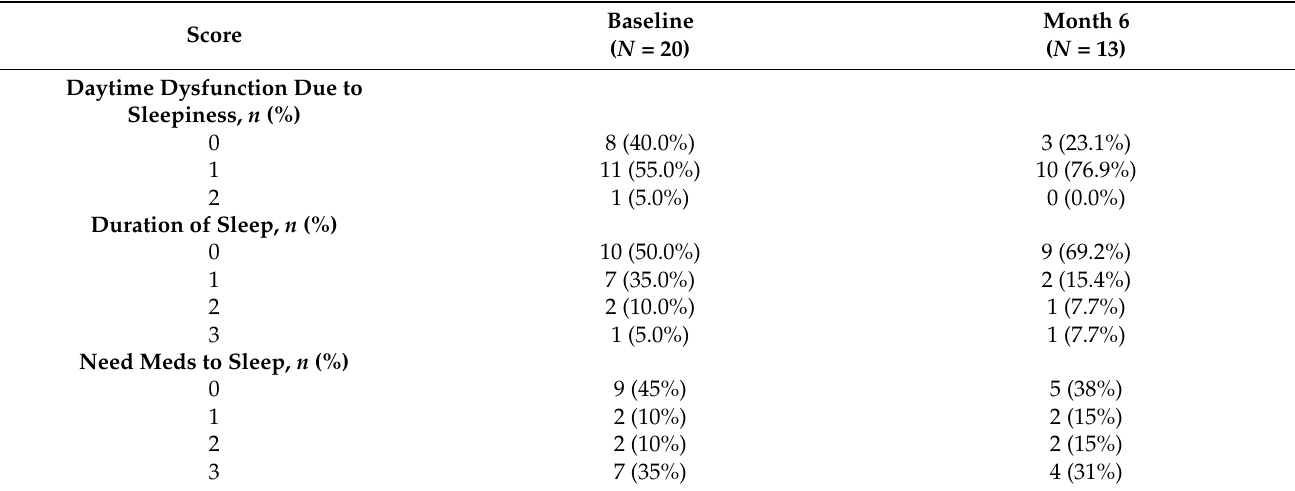
Table A2. PSQI scores—descriptive